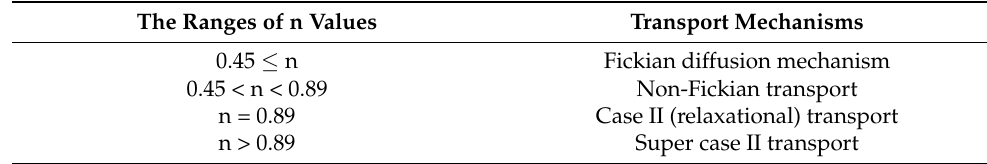
Table 4. Transport mechanism types according to the ranges of n